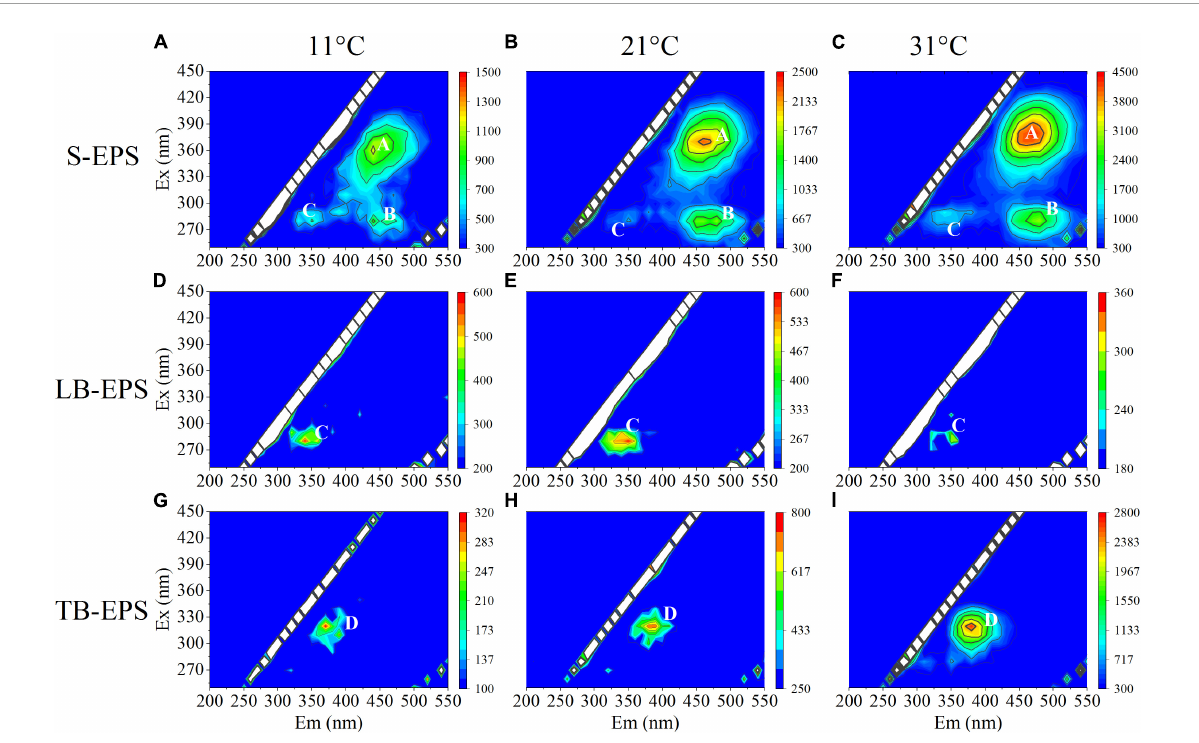
FIGURE3 EEM spectra of EPS fractions of A. flos-aquae at different temperatures (peak A and peak B standed for humic-like, peak C and peak D standed protein). (A–C) Represented the EEM diagram of S-EPS at 11, 21, and 31 ◦ C; (D–F) represented the EEM diagram of LB-EPS at 11, 21, and 31 ◦ C; (G–I) represented the EEM diagram of TB-EPS at 11, 21, and 31 ◦